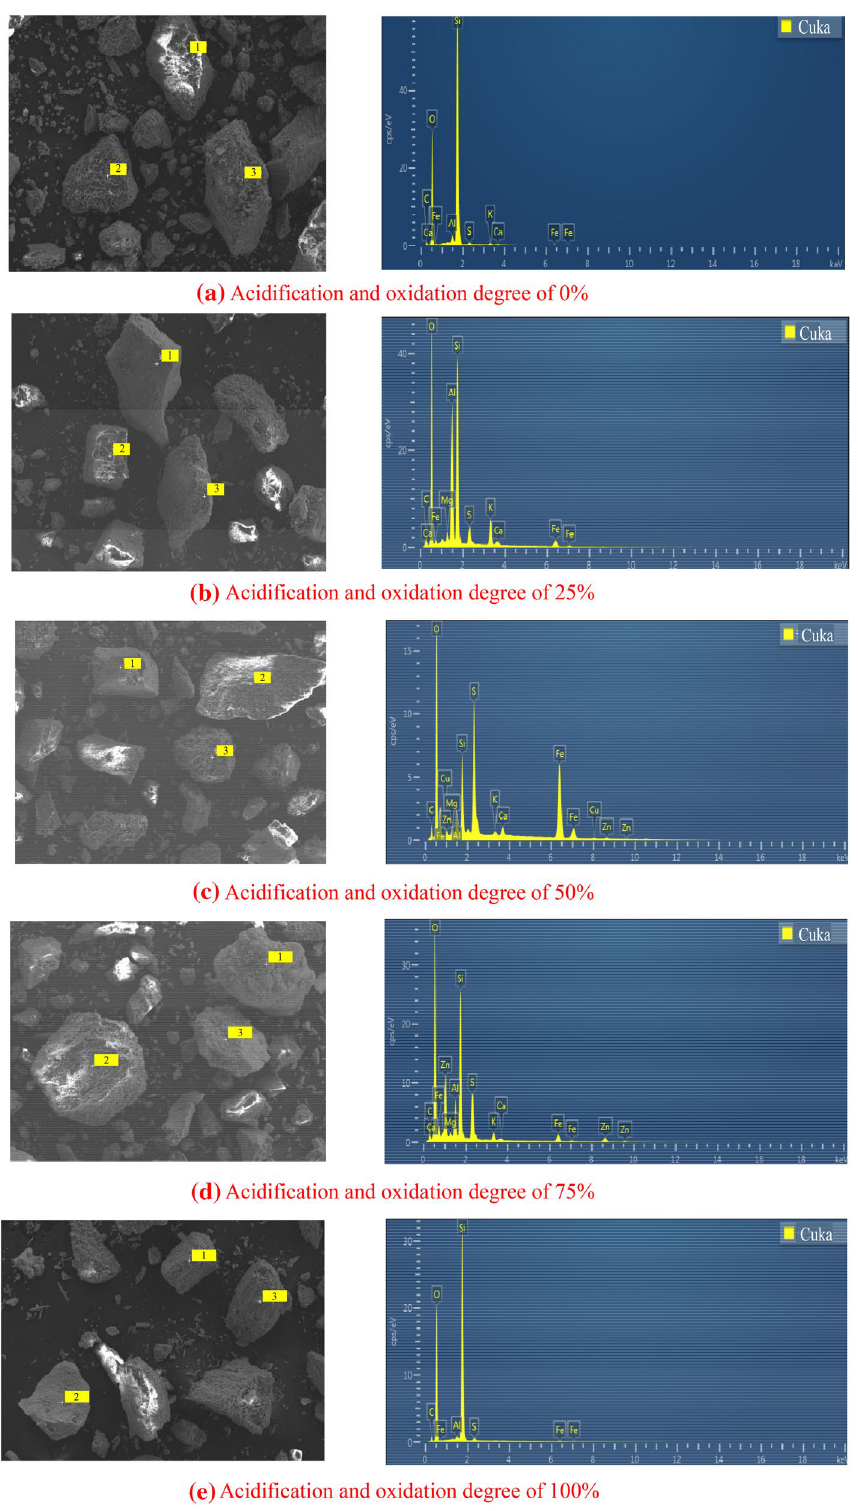
Figure 3. The EDS test point domain and element spectrogram of tailings sand particles with different oxidation and acidification